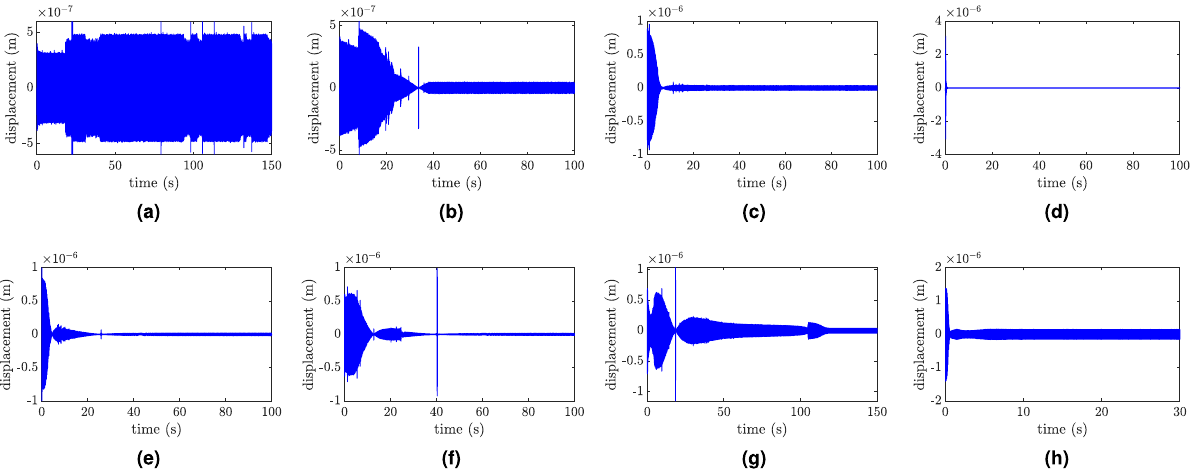
Figure 6. Tip displacement of the primary structure at different excitation frequencies: ( a ) f = 78 Hz, w 0 = 0.1 g ; ( b ) f = 85 Hz, w 0 = 0.1 g ; ( c ) f = 130 Hz, w 0 = 0.1 g ; ( d ) f = 140 Hz, w 0 = 0.1 g ; ( e ) f = 150 Hz,